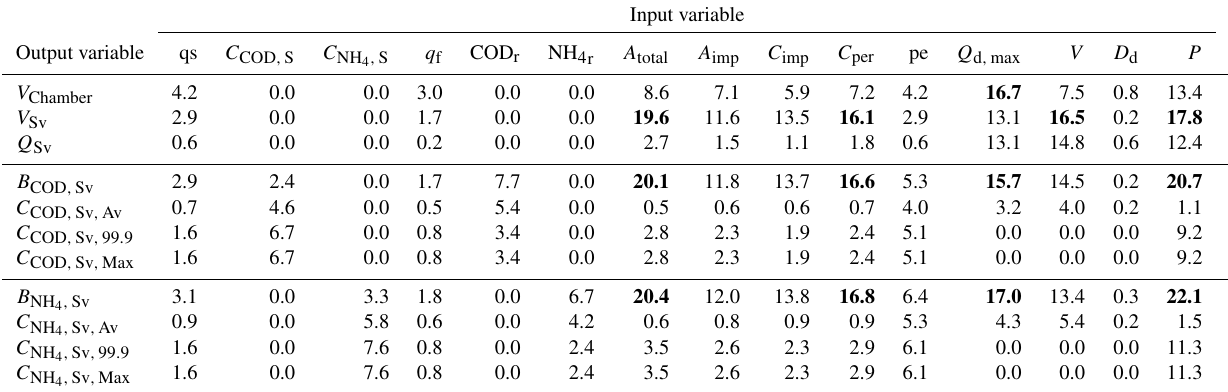
Table 1. Results of deterministic sensitivity analysis. Average percentage of change in model output caused by ± 10% change in model inputs (qs, C COD , S , C NH , COD r , pe, and P as time series; VAR(1) model for C COD , S and C NH 4 , S AR(1) conditioned for P ; see Appendix A for nomenclature definitions). Output change greater than 15% is considered very high. Variable C d (not shown in the table) leads to a percentage of change of less than 0.3%, while variables t fS and Lev ini (not shown in the table) lead to no change in the output. Values greater than 15 are shown in